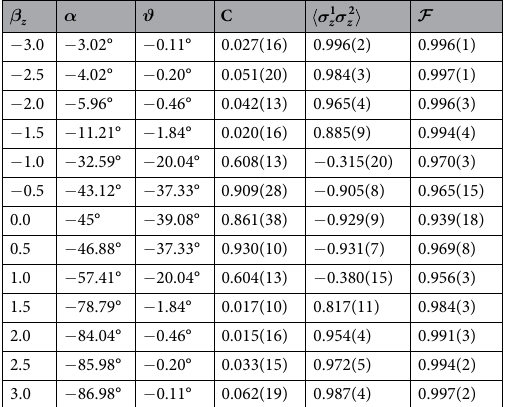
Table 1. The dimensionless magnetic field strength β z (here β x = 0.15), the angles of the HWPs α and ϑ , the measured concurrence  , the two-spin correlation σ σ the theoretical predictions  . Error bars indicate the statistical uncertainty and are estimated with Monte Carlo